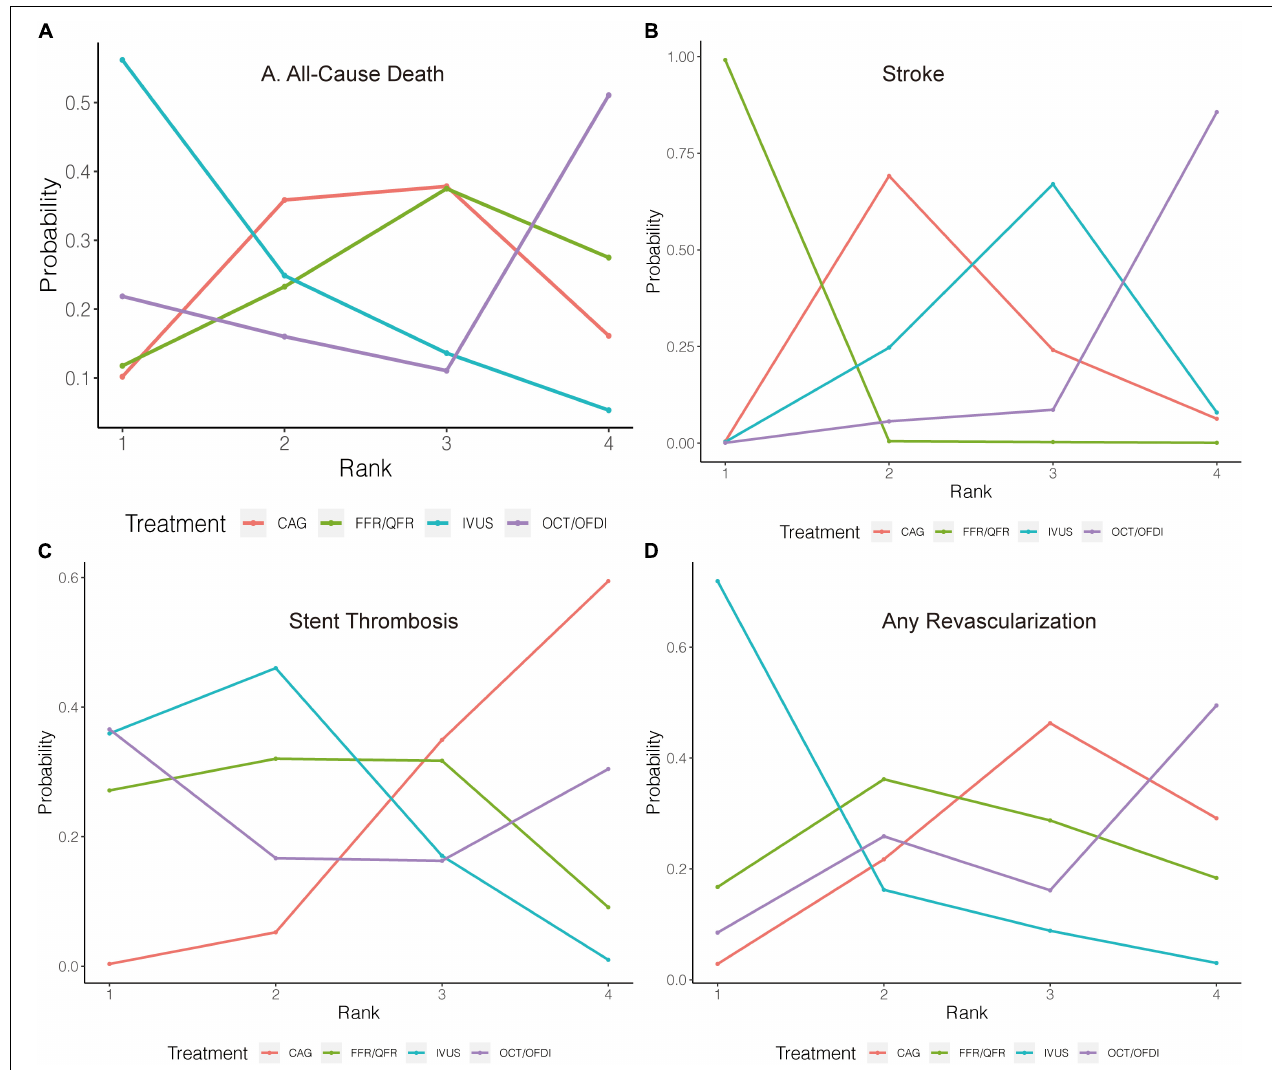
FIGURE 5 | Rank probability analysis for secondary outcomes among guidance modalities included in the network meta-analysis. Rank 1 is the best while rank 4 is the worst. For example, for all-cause death (A) , IVUS had the highest probability of ranking 1, CAG had the lowest probability of ranking 1. CAG, coronary angiography; FFR, fractional flow reserve; IVUS, intravascular ultrasound; OCT, optical coherence tomography; OFDI, optical frequency domain imaging; QFR, quantitative flow ratio. (A) All-cause death. (B) Stroke. (C) Stent thrombosis. (D) Any